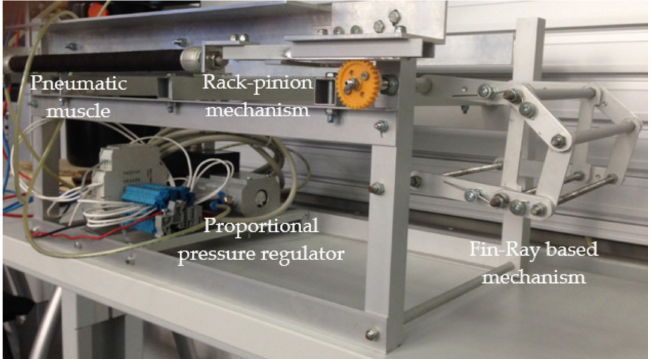
Figure 10. Construction of the rehabilitation equipment of the wrist.